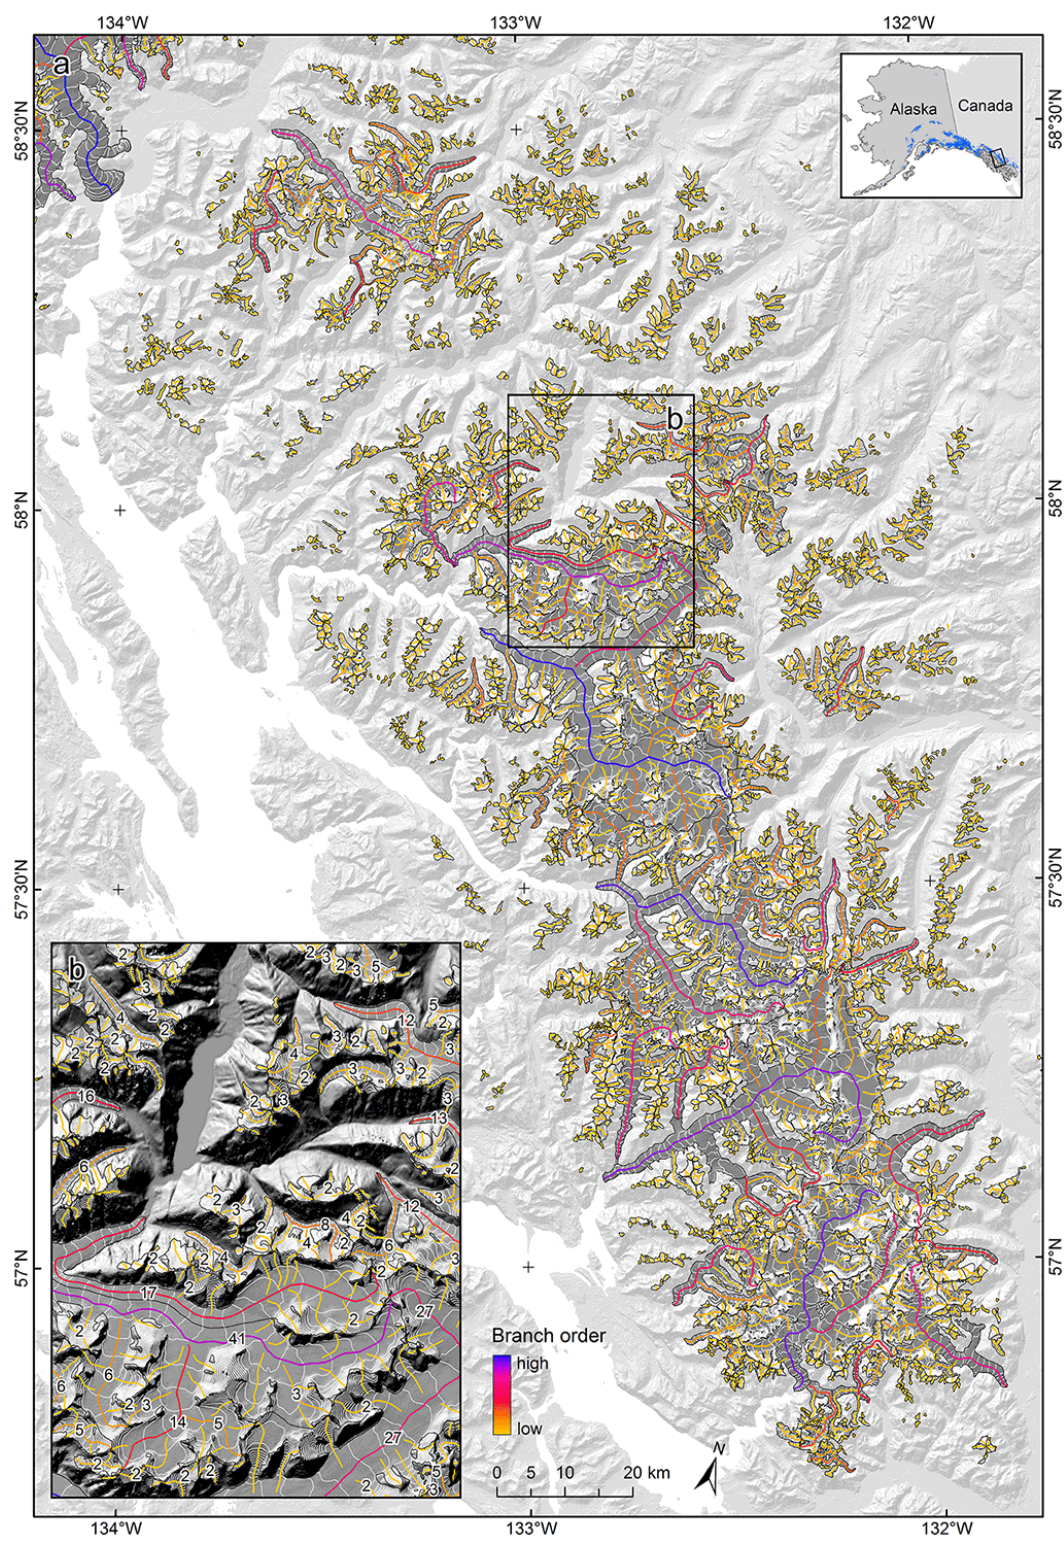
Fig. 10. (a) Derived centerlines for glaciers in the Stikine Icefield area. The line colors indicate branch order. The shaded-relief background is derived from the SRTM DEM. 50m contours are shown as white lines. Inset (b) shows a subarea with labels quantifying the branch orders greater than